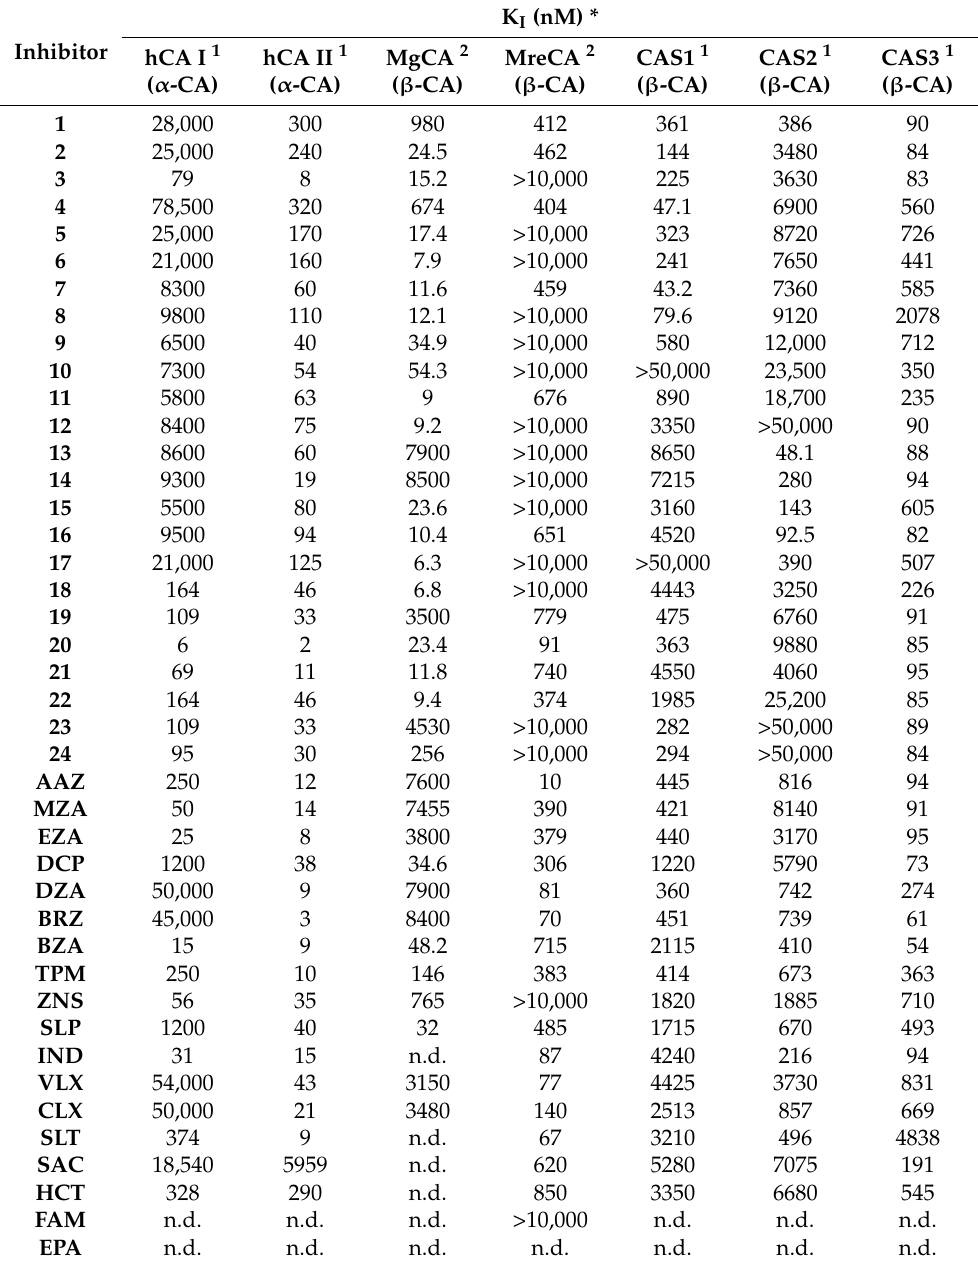
Table 1. Inhibition data of human isoenzymes (CA I and CA II) and fungal CAs (MreCA, MgCA, CAS1, CAS2, CAS3; Figure 1) by a stopped-flow CO 2 hydrase assay. The other fungal CAs have been previously reviewed by Elleuche and Poggeler (see references